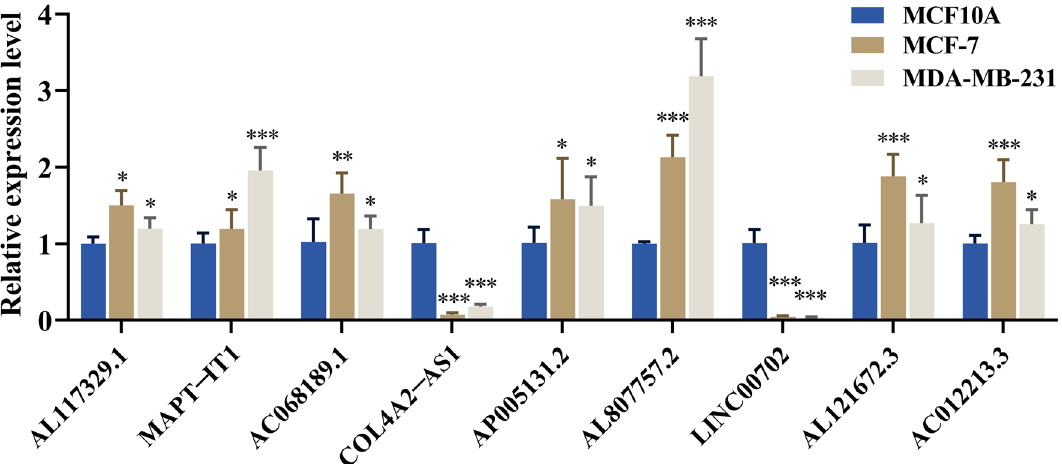
Figure 9. The relative expression levels of the nine lncRNAs in MCF-10A, MCF-7 and MDA-MB-231 by qRT- PCR (*P < 0.05; **P < 0.01, ***P <